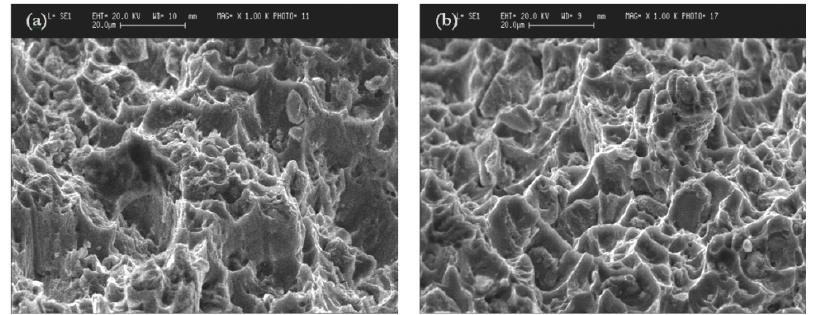
Figura 15: Micrografie SEM delle superfici di frattura dei provini di resilienza